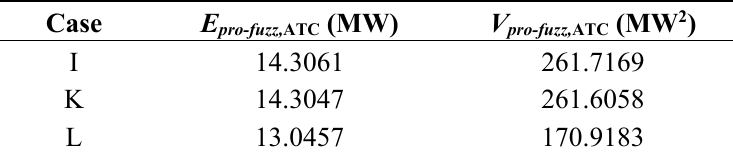
Table 10. The results of Case I, Case K and Case L.